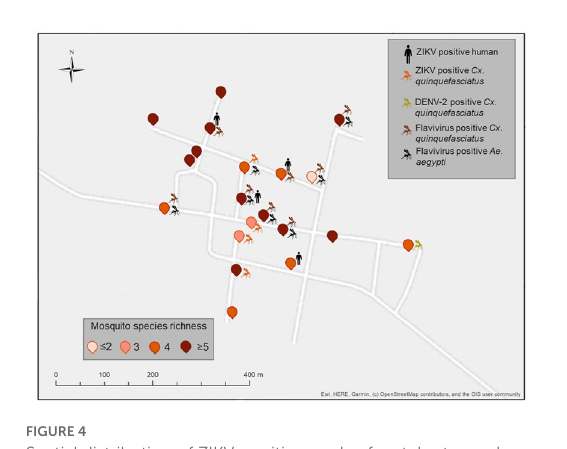
FIGURE4 Spatial distribution of ZIKV-positive pools of vertebrates and mosquitoes from Paraiso (PSO), Yucatan, Mexico. Positive households include the icons of vertebrates or mosquito pools positive in each dwelling. Mosquito species identity for each household is shown in Supplementary Table 2. Map coordinates were removed to protect the privacy of the patients